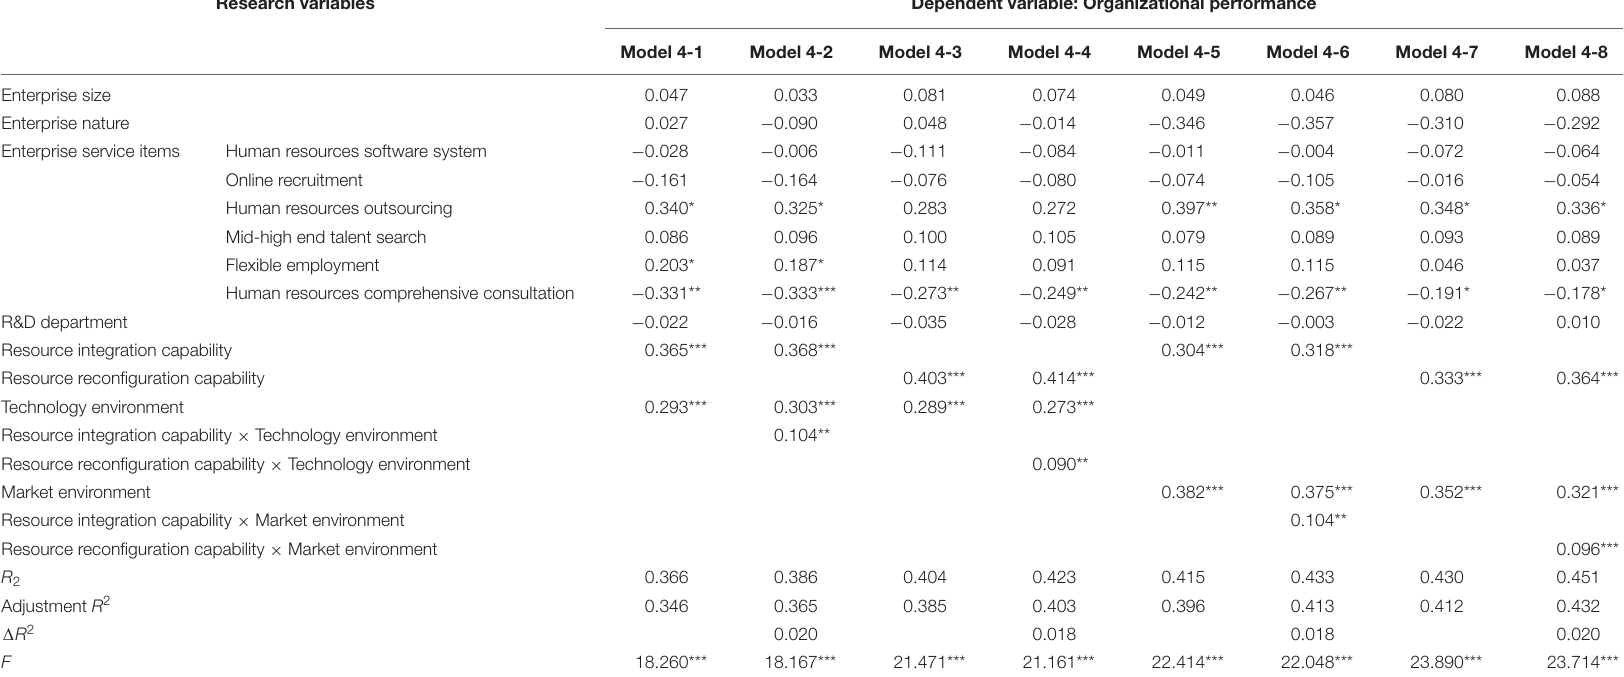
TABLE 11 | The moderation effect of dynamic capability on organizational